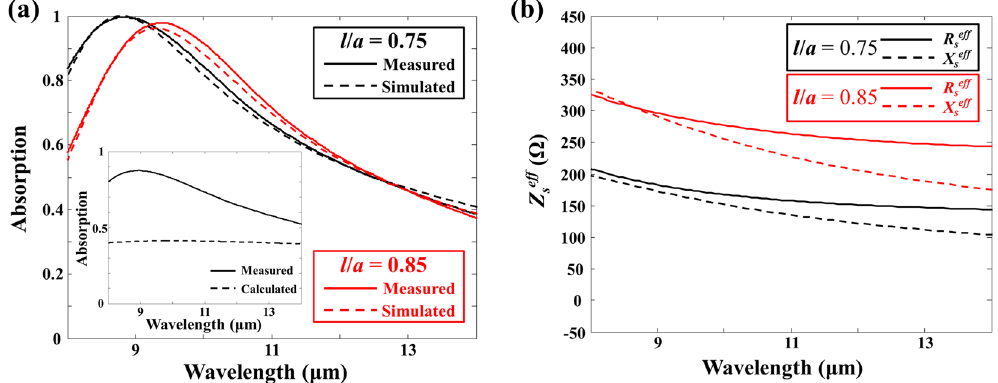
Figure 5. ( a ) Measured (solid curves) and simulated (dashed curves) absorption spectral responses of the metasurface absorbers for l = 0.75 μ m (black curves) and l = 0.85 μ m (red curves) with identical Ni thicknesses of t = 12 nm. The inset shows the measured (black solid) absorption spectral response of Salisbury screen absorbers with a Ni thickness of t = 12 nm and calculated (black dashed) absorption spectral responses of Salisbury screen absorbers with R s = 50 Ω. ( b ) Retrieved effective surface impedances of the metasurfaces for l = 0.75 μ m (black curves) and l = 0.85 μ m (red curves) with identical Ni thicknesses of t = 12